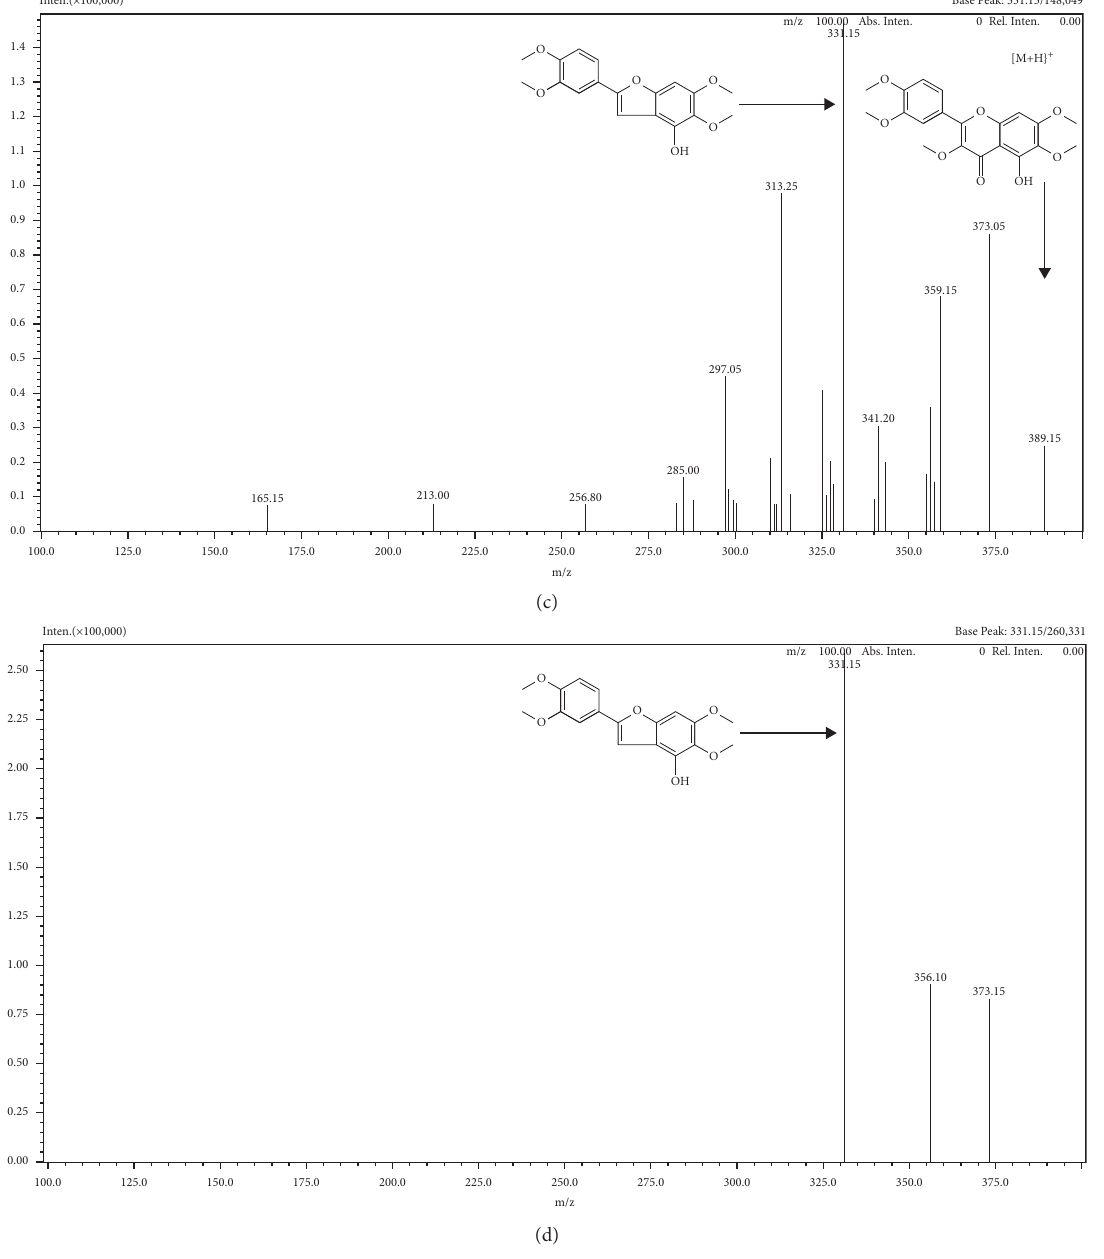
Figure 2: The MS/MS spectrums of TMEA (a) and IS (c), and the main corresponding product ion of TMEA (b) and IS